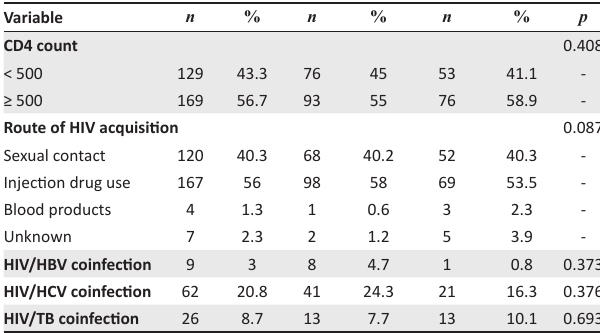
TABLE 2b: Clinical status of depressed and non-depressed participants.